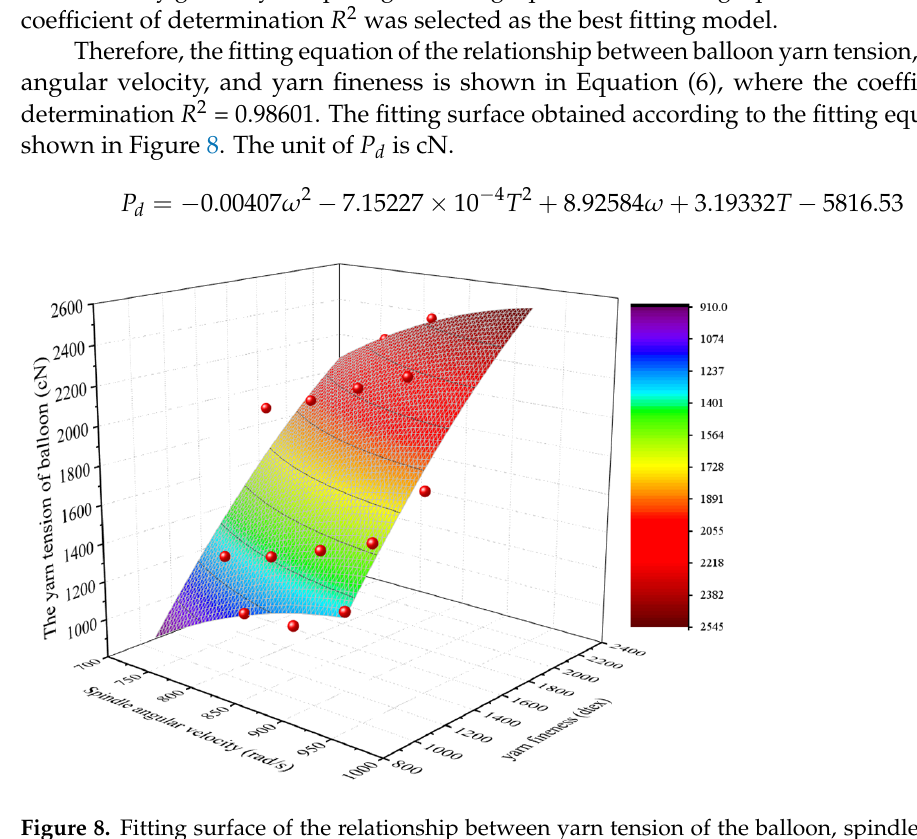
Table 5. Measured and predicted twisting tension error analysis.